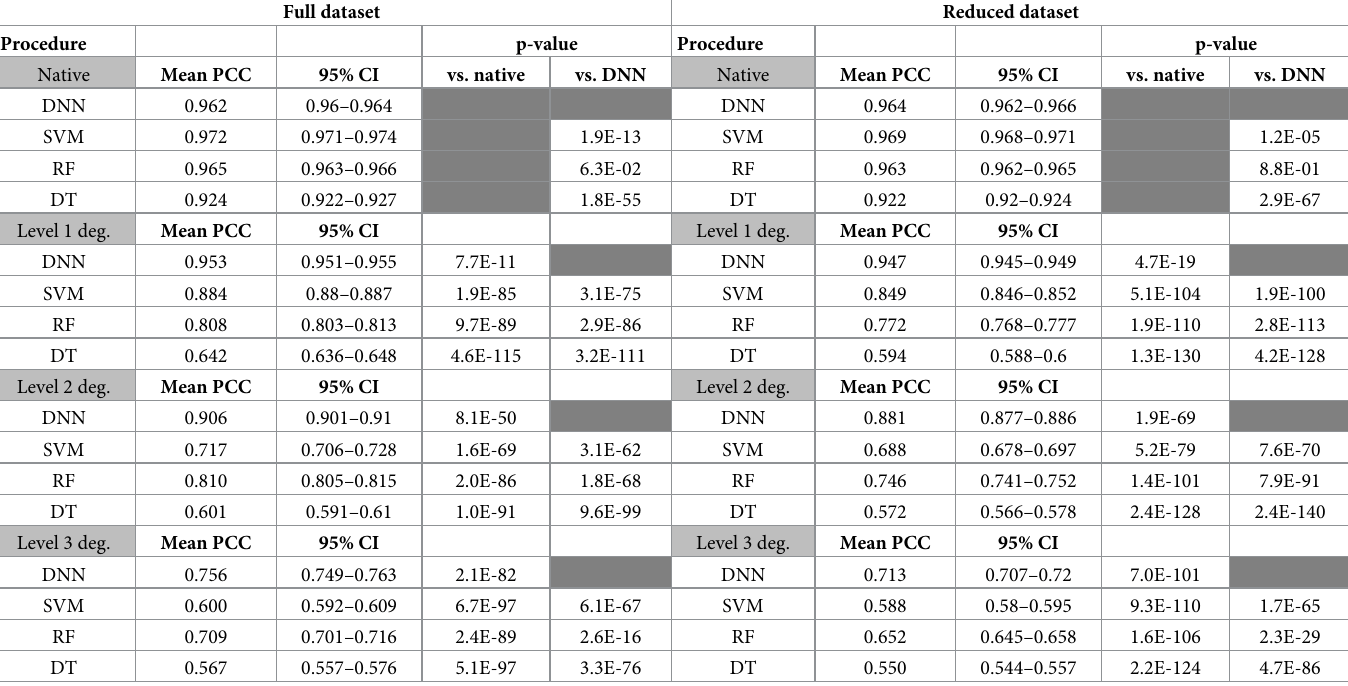
Table 2. Comparison of diagnostic accuracy (by PCC) for investigated machine-learning